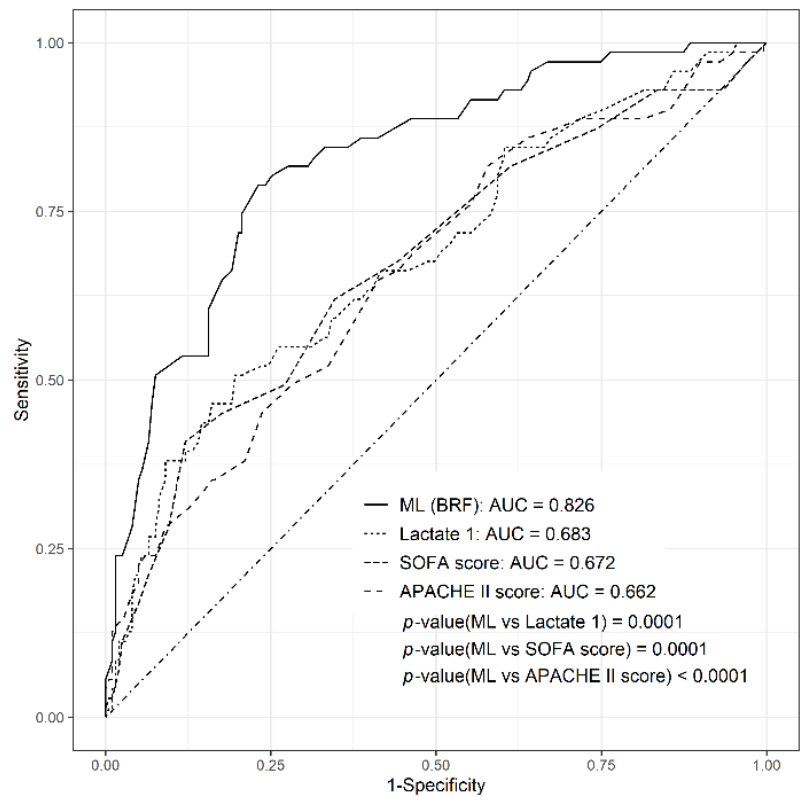
Figure 2. AUCs (areas under the curve) comparing the ML (machine learning) model with SOFA (Sequential Organ Failure Assessment), APACHE (Acute Physiology and Chronic Health Evaluation) II score, and initial lactate level for 28-day mortality in the test set.